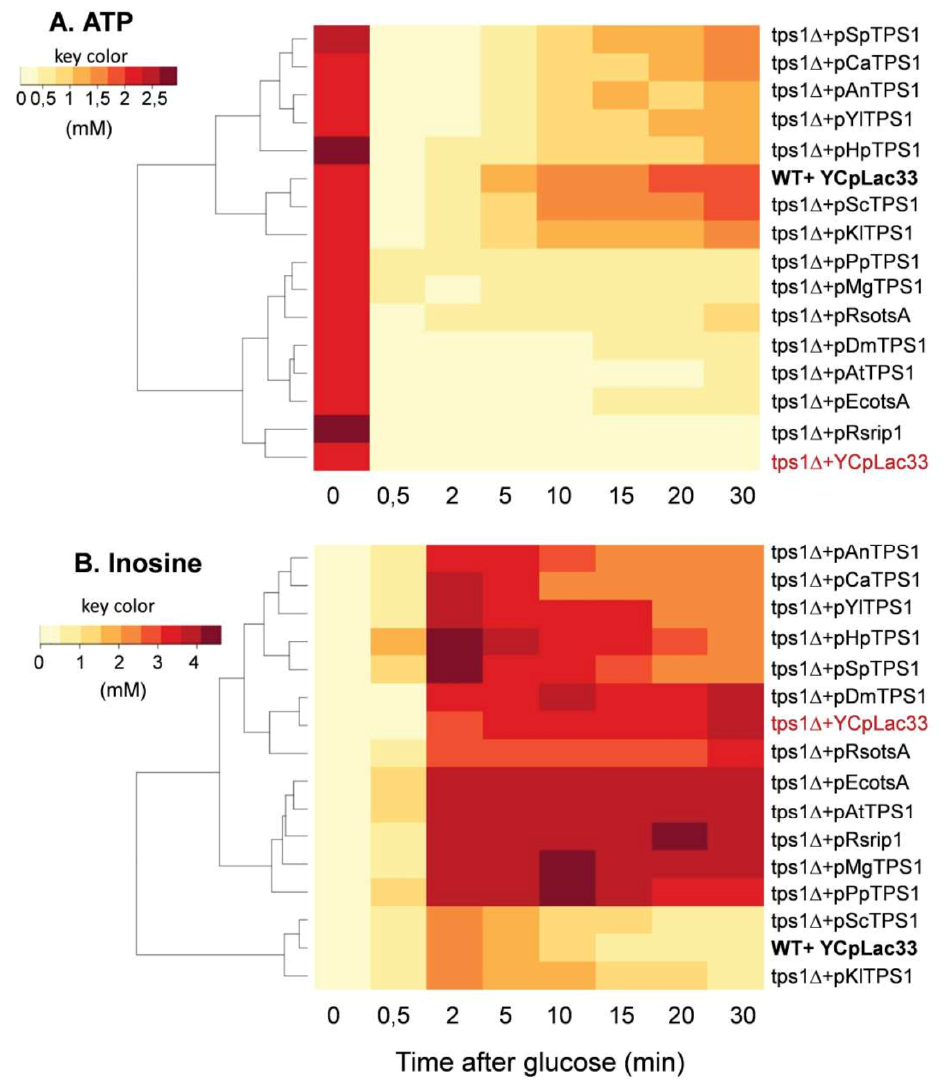
FIGURE 6 : Heat map rep- resentation of the change of ATP (A) and inosine (B) concentration in S. cere- visiae tps1 mutant expressing TPS1 from different organisms in response to a glucose pulse. Same procedure as in Fig.